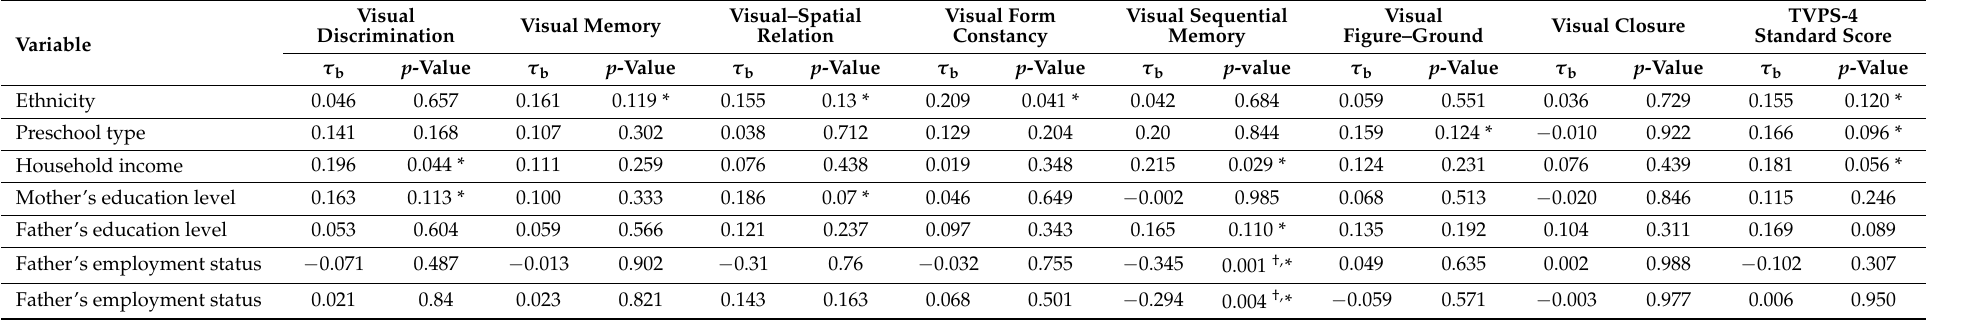
Table 4. Kendall’s tau-B analyses for the association between TVPS-4 standard and scaled scores, as well as socioeconomic